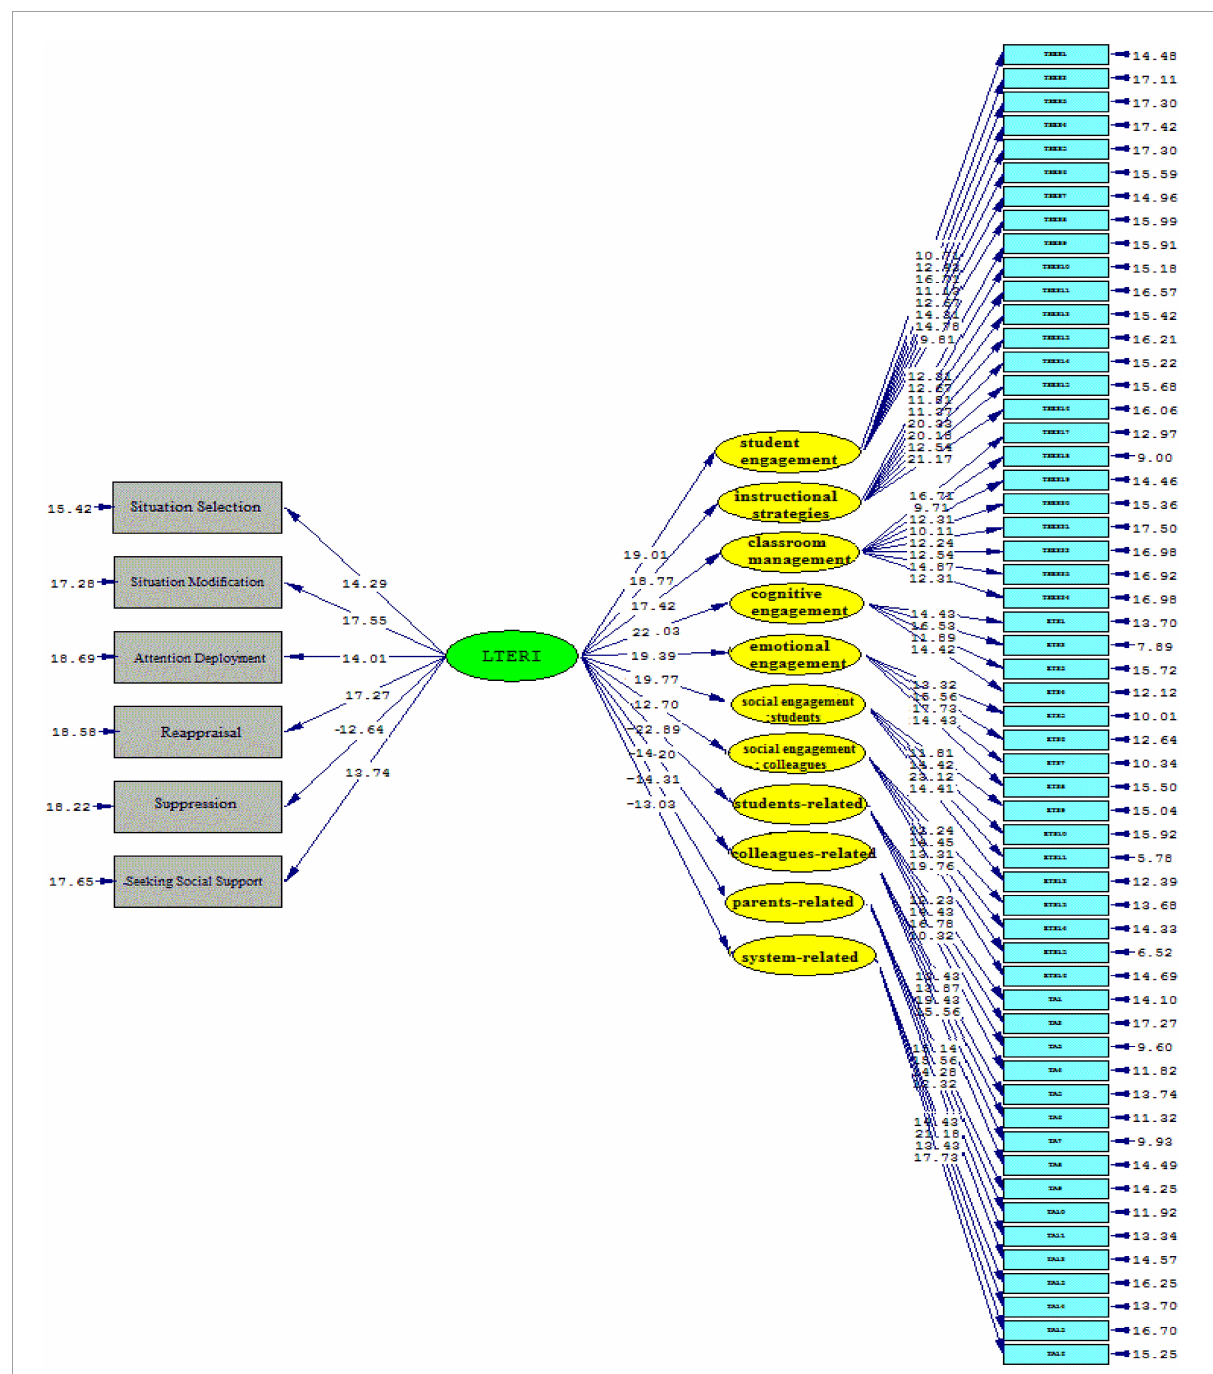
FIGURE5 T -values for path coefficient significance (Model